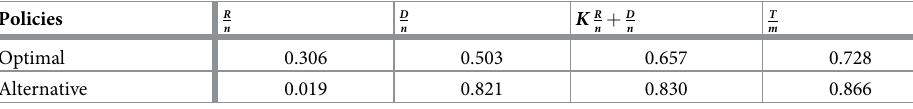
, D and T under the optimal and alternative n n m